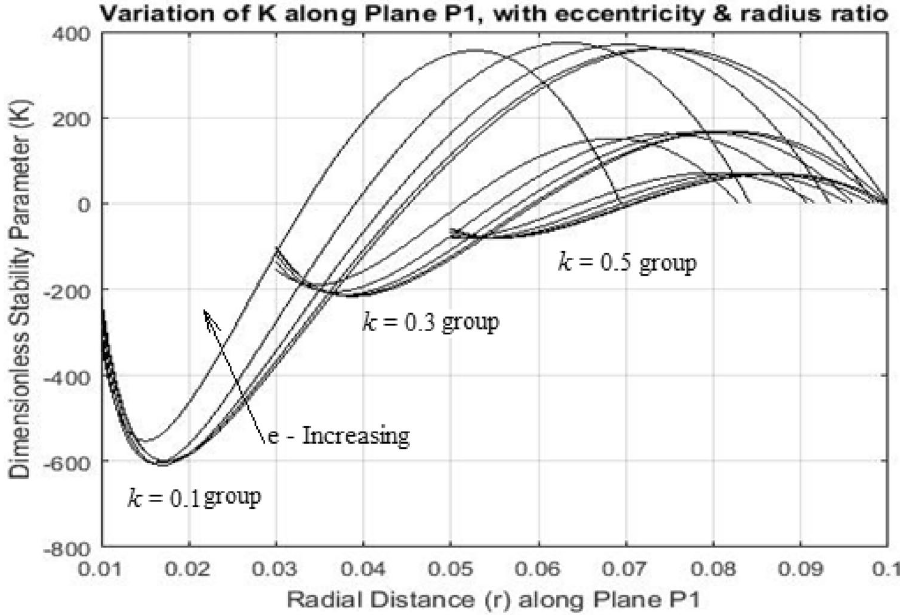
Fig. 3 Effect on K with varia- tion in r , k and ɛ along plane P